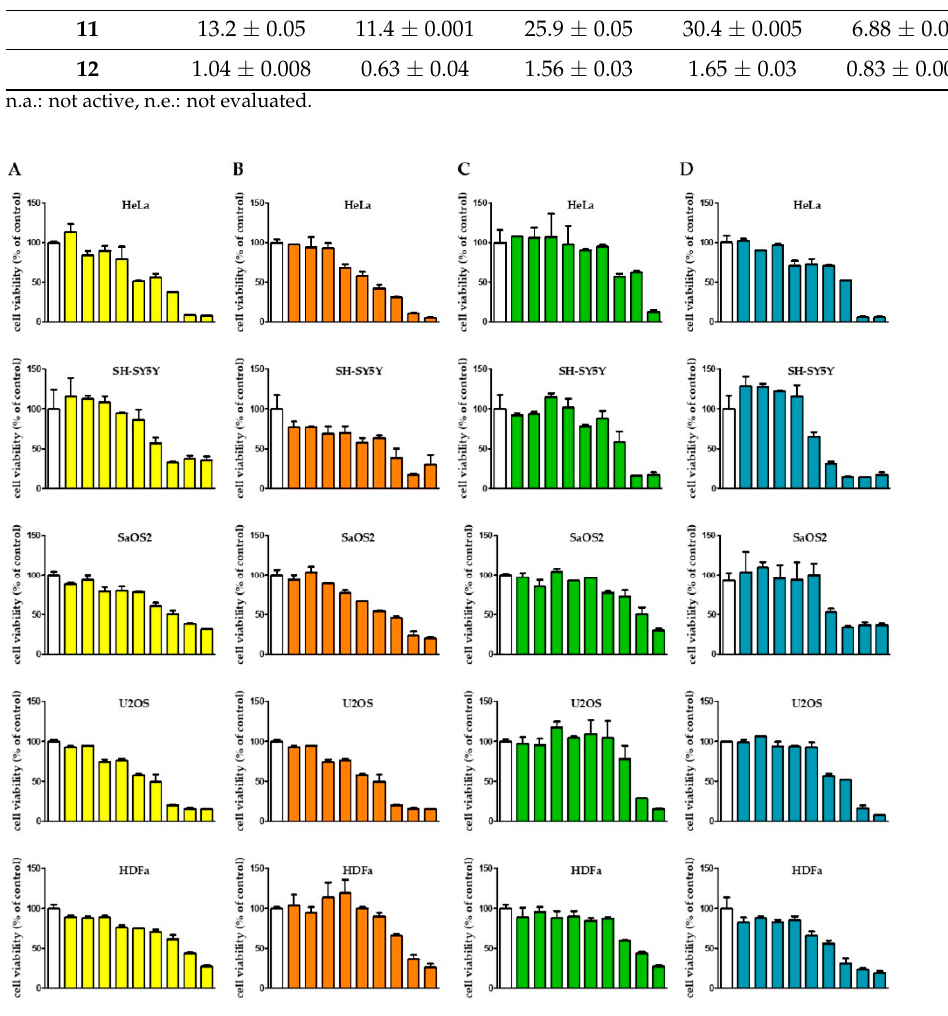
Figure 4. Effects of compounds on the viability of transformed and non-transformed human cells. HeLa, SH-SY5Y, SaOS2, U2OS, and HDFa were incubated for 48 h with increasing concentrations of compounds 8 , 9 , 11 , and 12 (from 0.01 to 200 μ M). Viability was evaluated using MTT tests as reported in Materials and Methods. ( A ) Compound 8 . ( B ) Compound 9 . ( C ) Compound 11 . ( D ) Compound 12 . The white bars correspond to the control. Results were expressed as means ± SDs of three independent experiments.